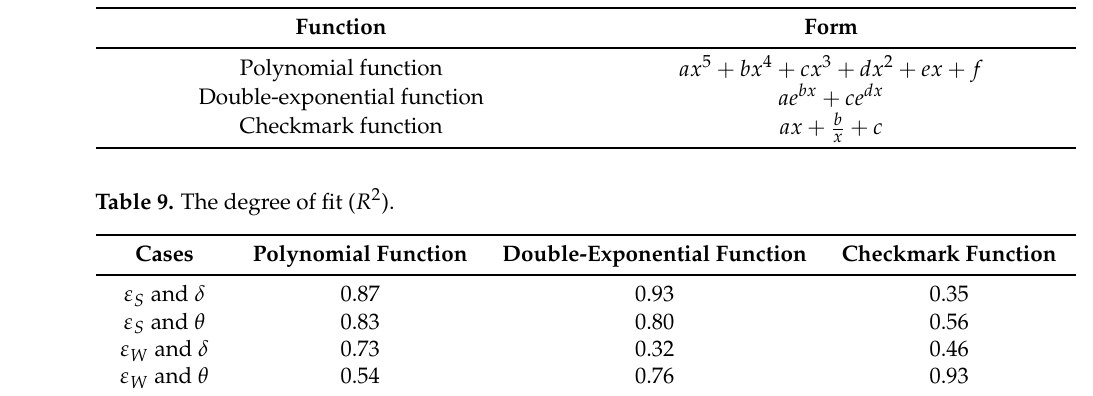
Table 8. The fitting functions.